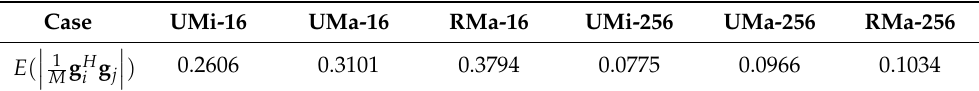
(cid:12) (cid:12) (cid:12)